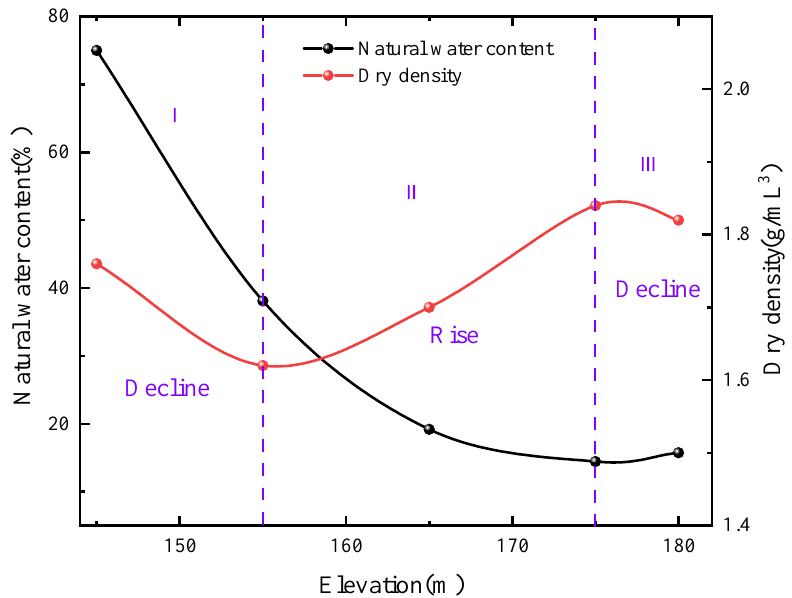
Figure 3. Density and natural moisture